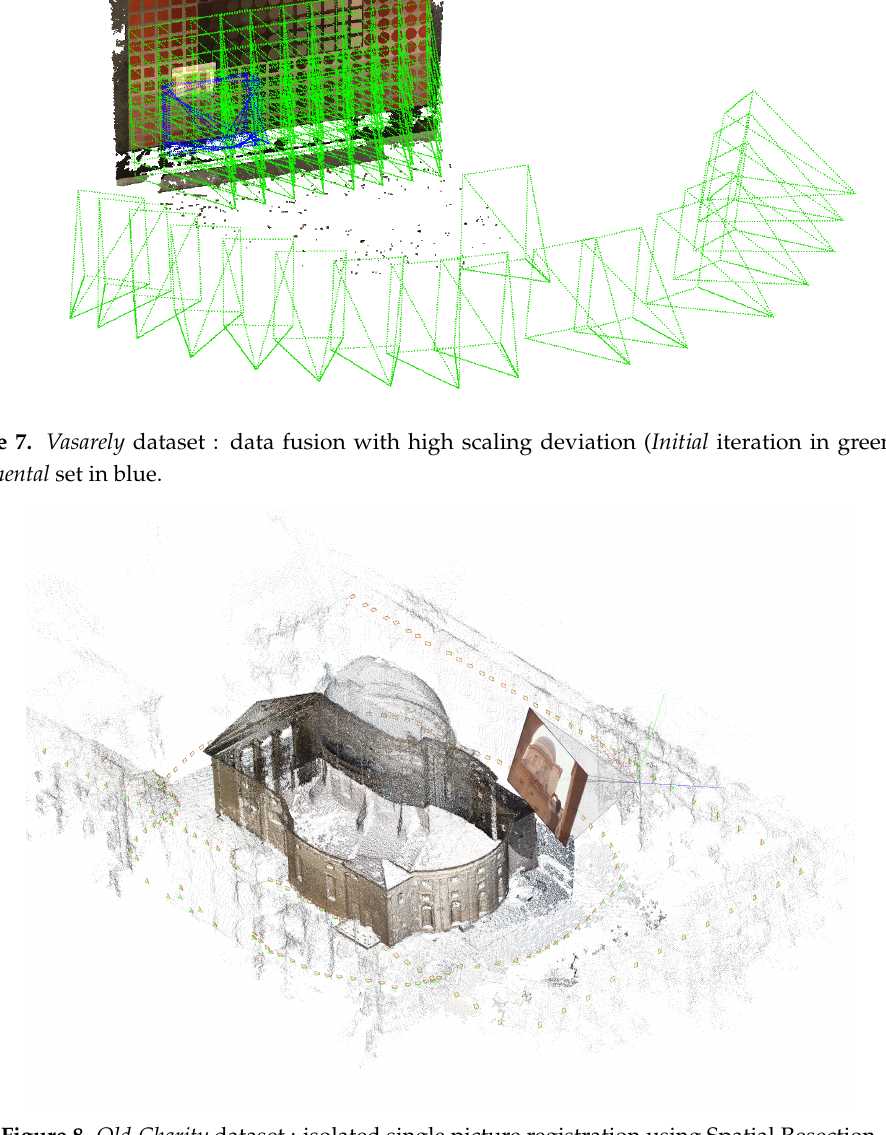
Figure 8. Old-Charity dataset : isolated single picture registration using Spatial